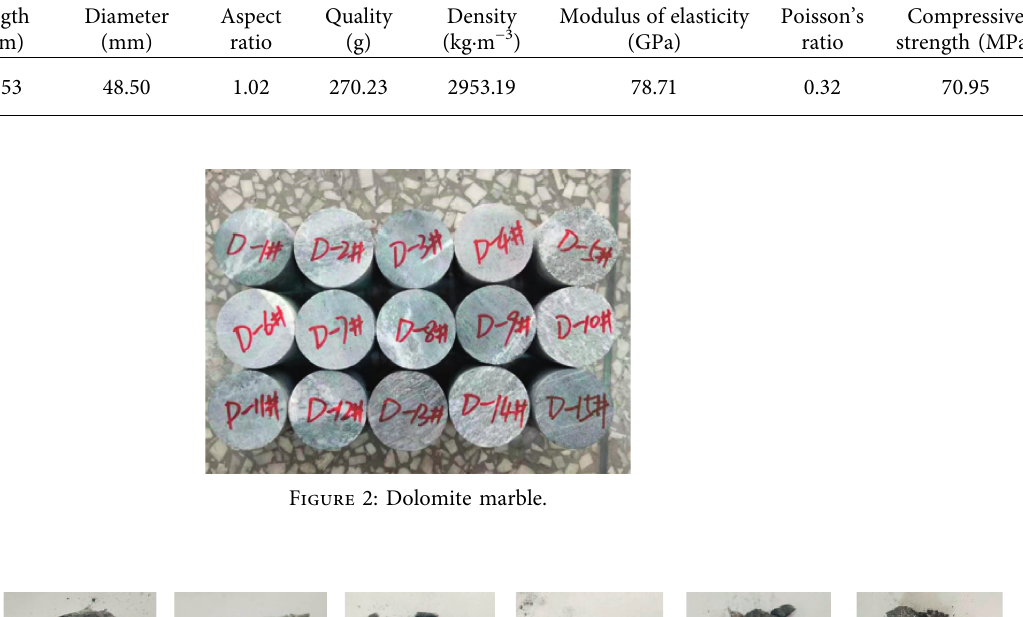
Table 1: Average value of physical parameters of test specimen.